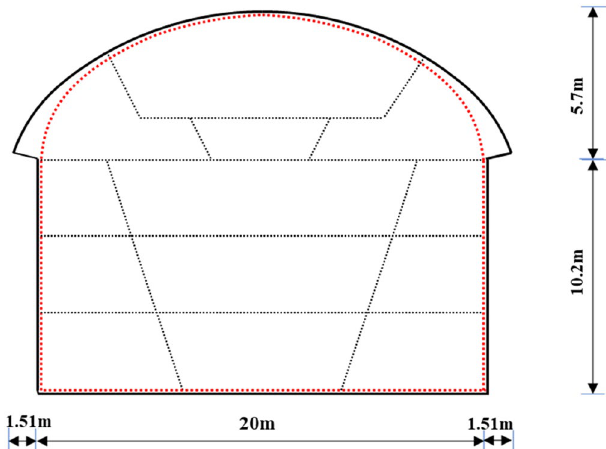
Figure 3. A section of the primary structure of the station.